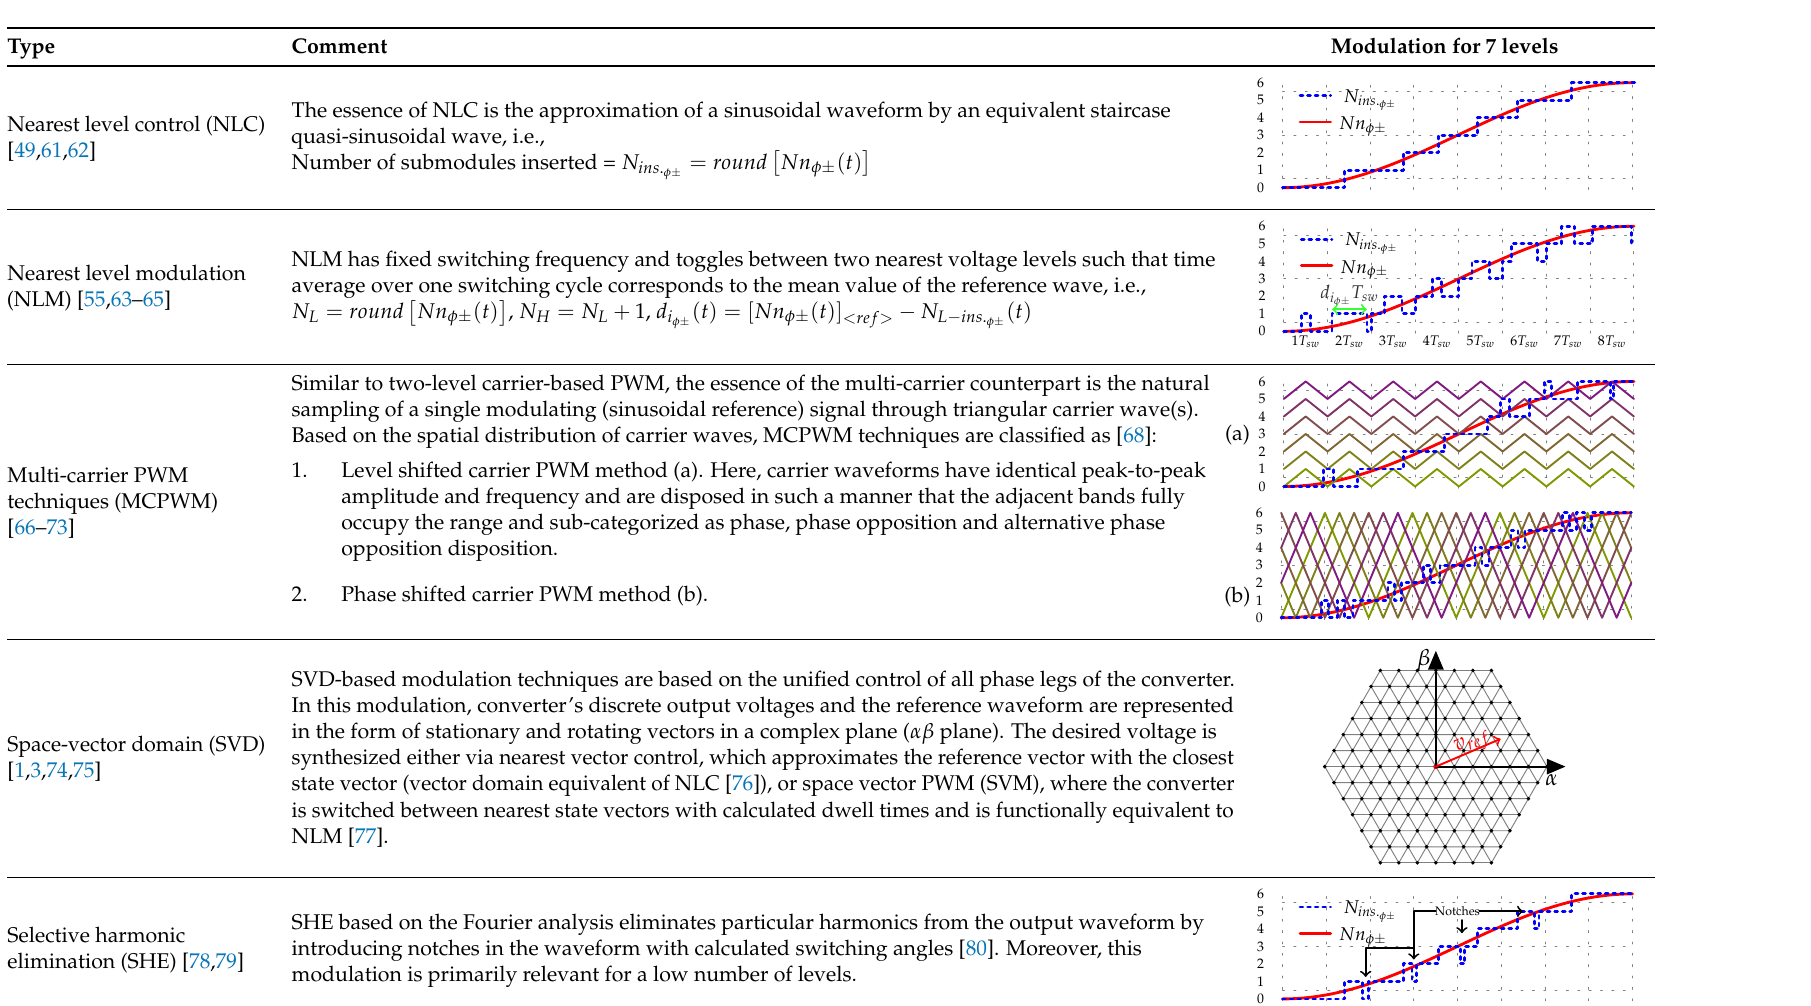
Table 3. Module-Level Modulation